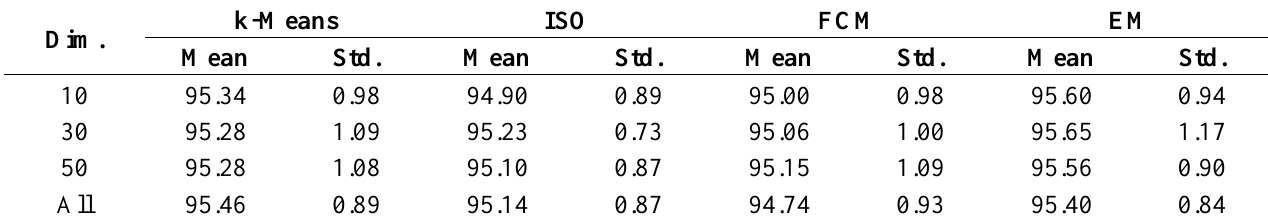
Table 9. Classification accuracies for the Indian Pines image with different spectral dimensions for